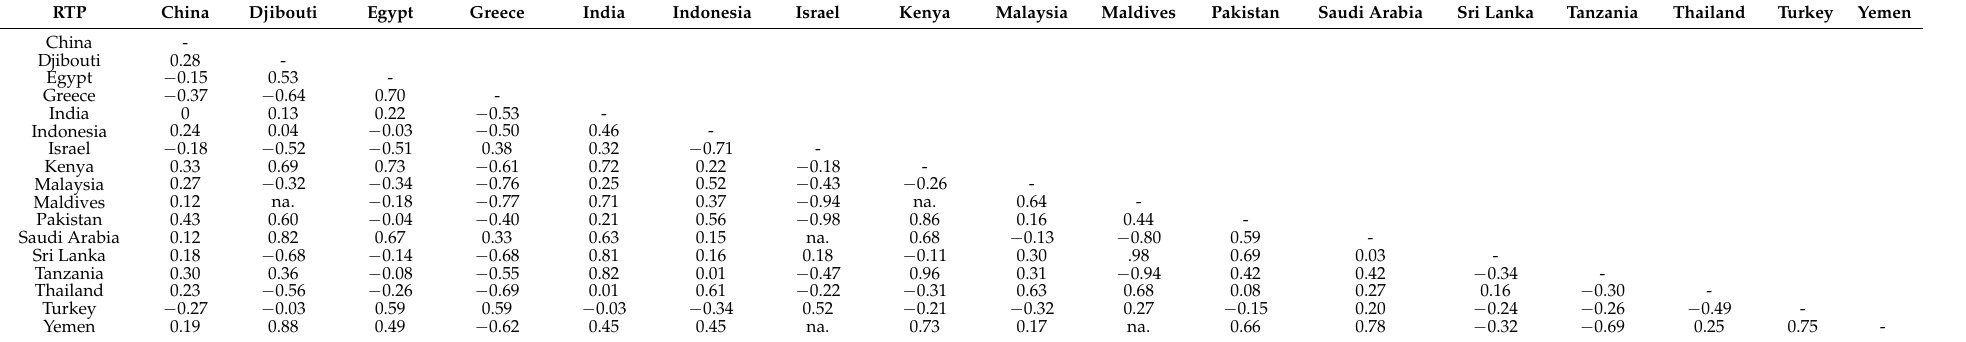
Table 7. RTP index for countries in the China–Central Asia–West Asia Economic Corridor